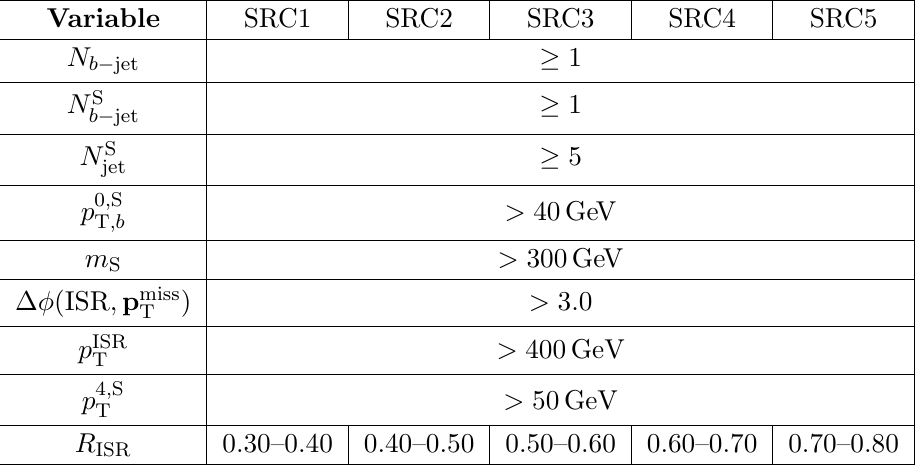
Table 2. Selection criteria for SRC, in addition to the common preselection requirements described in the text. The signal regions are separated into windows based on ranges of R ISR